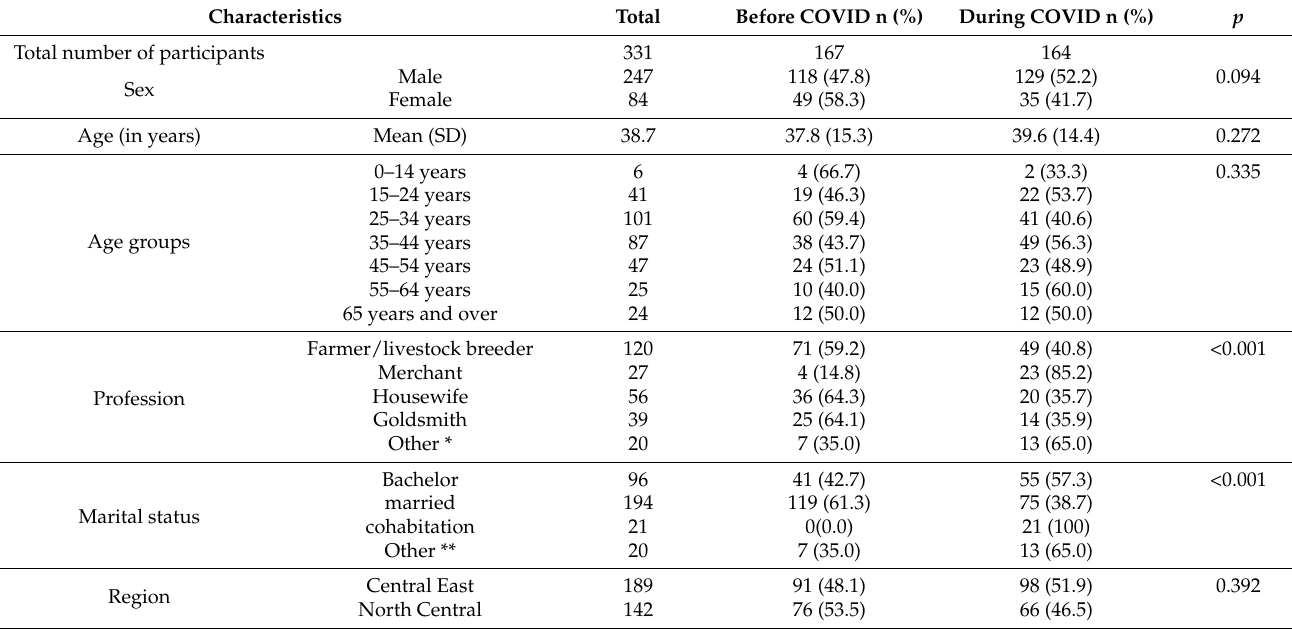
Table 1. Sociodemographic characteristics of recruited TB patients during the ‘before’ and ‘during’ COVID periods.